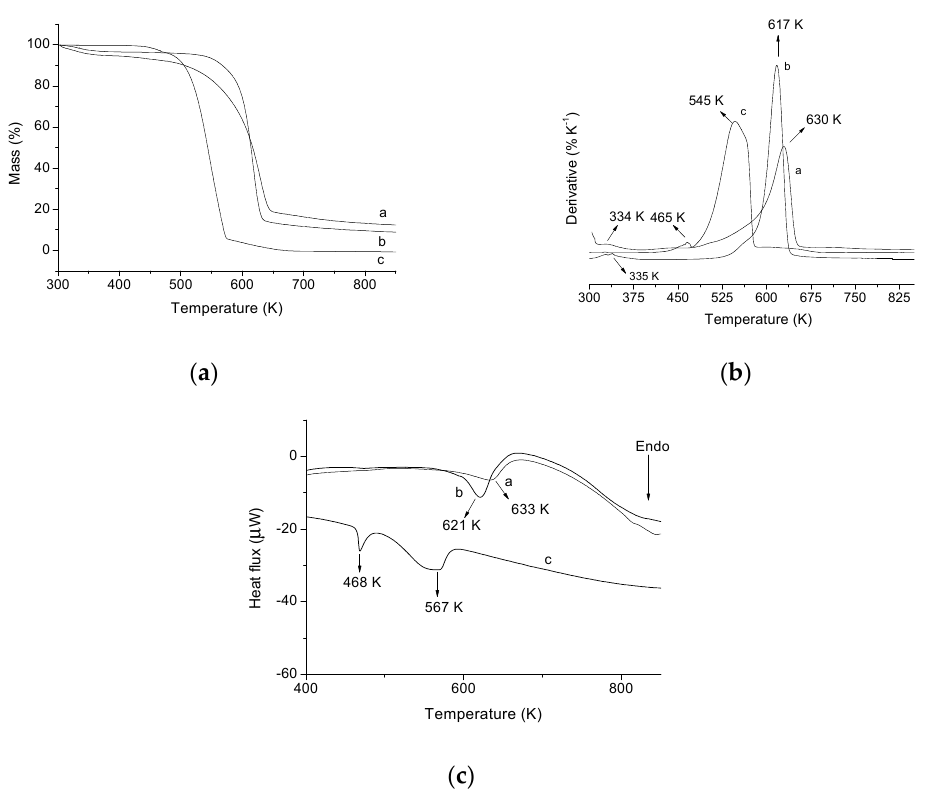
Figure 10. ( a ) Thermogravimetric curve (TG) of CN polymer before ( a ) and after ( b ) AMI adsorption and pure AMI ( c ); ( b ) derived from thermogravimetric curve (DTG) of CN polymer before ( a ) and after ( b ) AMI adsorption and pure AMI ( c ); ( c ) DSC of CN polymer before ( a ), after ( b ) and AMI adsorption and pure AMI (C).